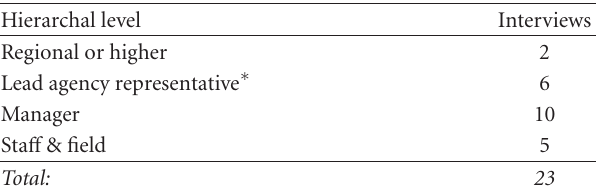
Table 2: Summary of interviews by hierarchical position rank for 23 natural resource managers involved in the management and planning of the Papah¯anaumoku¯akea Marine National Monument. The average tenure (years involved in management and planning in the NWHI) of interviewees was 6.98 years (median = 5